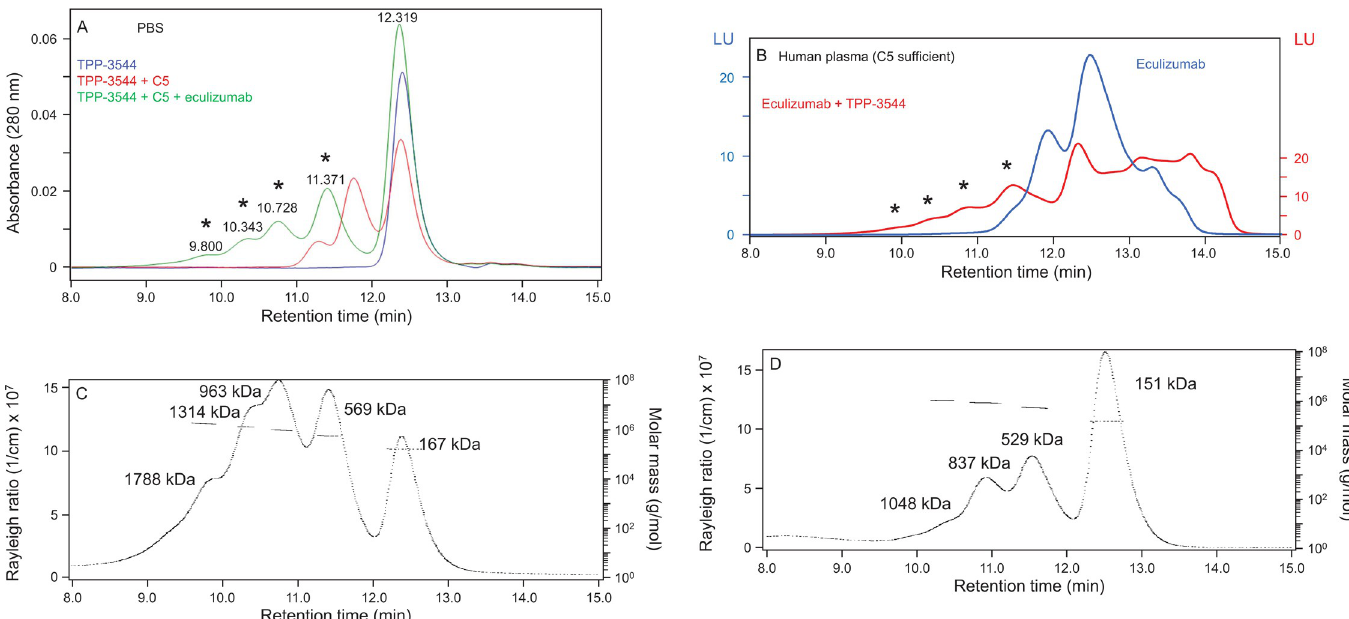
Fig 4. TPP-3544 induces the formation of very large complexes in the presence of eculizumab and C5. (A) TPP-3544 (700 nM) alone, in the presence of C5 (400 nM), or in the presence of C5 (400 nM) and eculizumab (700 nM) in PBS. Large, early-eluting peaks observed in the presence of TPP-3544, C5, and eculizumab are denoted with asterisks. (B) Reconstitution of Alexa Fluor 488-eculizumab (700 nM) in 80% human plasma in the absence or presence of TPP-3544 (700 nM). Early-eluting peaks observed in the presence of both the labeled eculizumab and TPP-3544 are denoted with asterisks. Data were plotted to normalize total chromatogram fluorescence area under the curve between the two treatment groups. (C) Rayleigh ratios and molar masses of complexes formed among TPP-3544 (700 nM), C5 (400 nM), and eculizumab (700 nM) in PBS. (D) Rayleigh ratios and molar masses of complexes formed among TPP-3544 (3500 nM), C5 (400 nM), and eculizumab (700 nM) in PBS. Abbreviations: C5 = complement component 5; LU = luminescence units; PBS = phosphate-buffered saline.